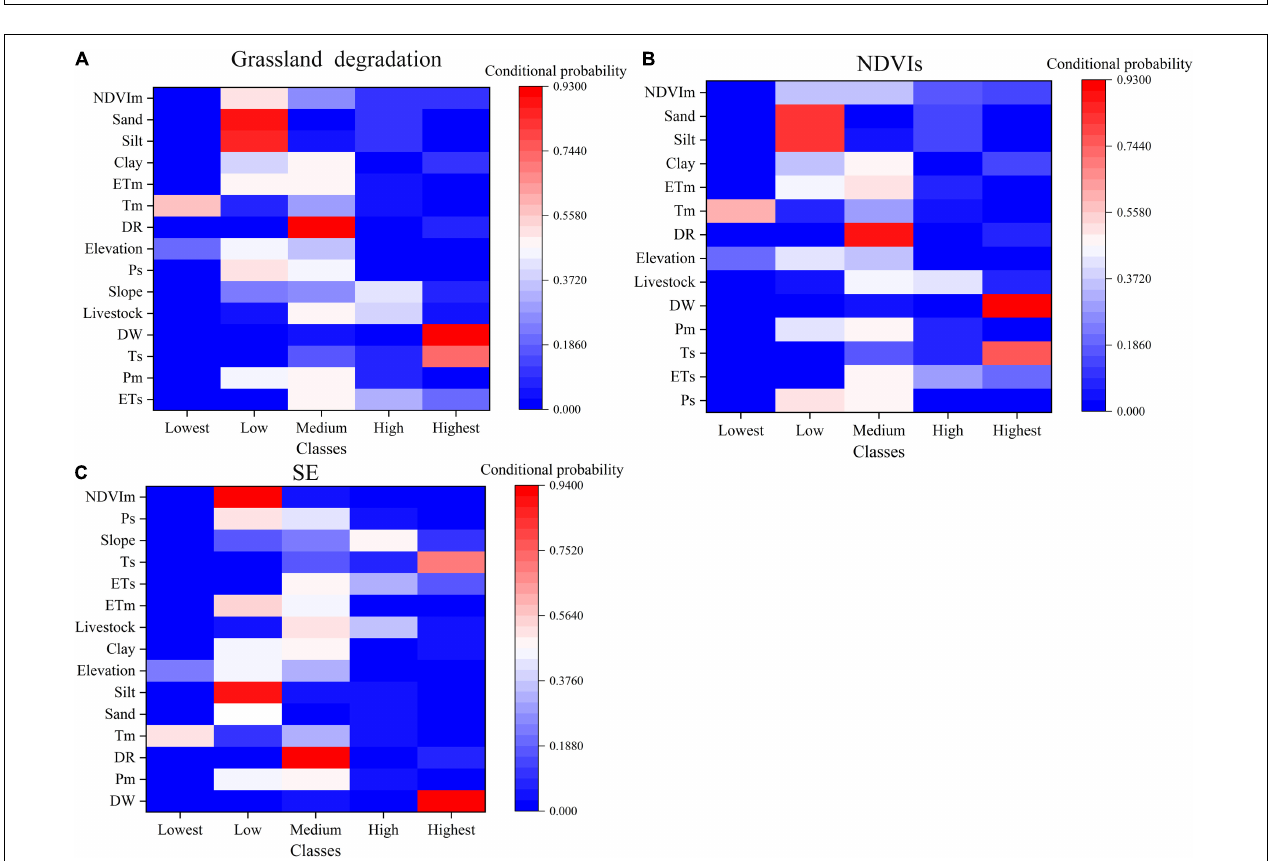
FIGURE 10 | Heat maps showing the conditional probabilities driving NDVIs, SE, and grassland degradation. (A) Grassland degradation. (B) NDVIs, slope of NDVI change. (C) SE, shrub-encroached grasslands.